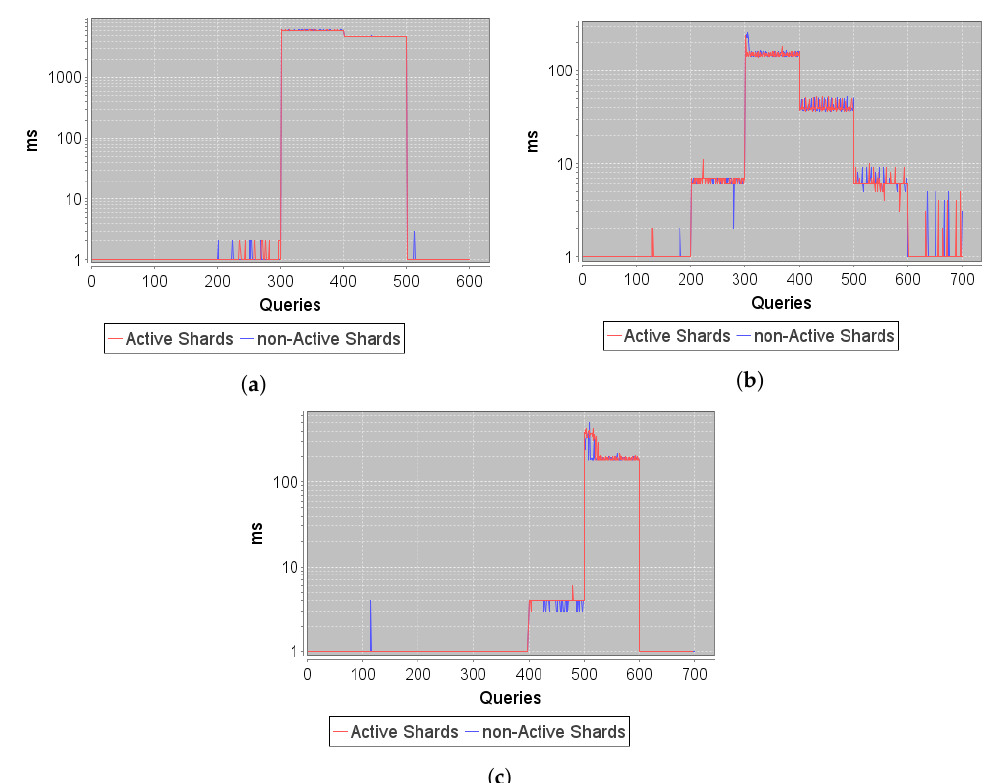
Figure 9. Comparison between access to active and inactive shards. Response time in ms (millisec- onds). ( a ) Dataset-1 queries. Access from non-active shards or from active shards. ( b ) Dataset-2 queries. Access from non-active shards or from active shards. ( c ) Dataset-3 queries. Access from non-active shards or from active